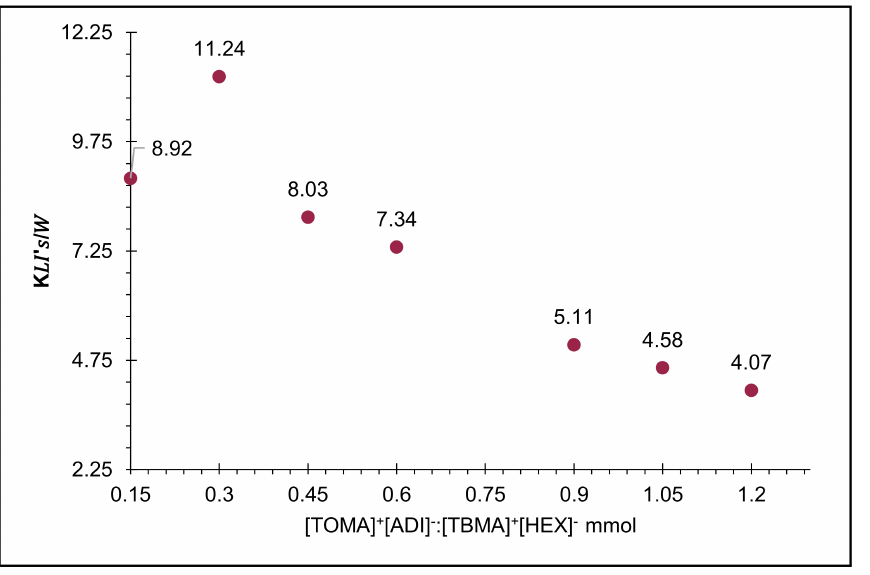
Figure 4. Average results of distribution coefficient calculations of biphasic systems: ILs/water (K IL’s/W